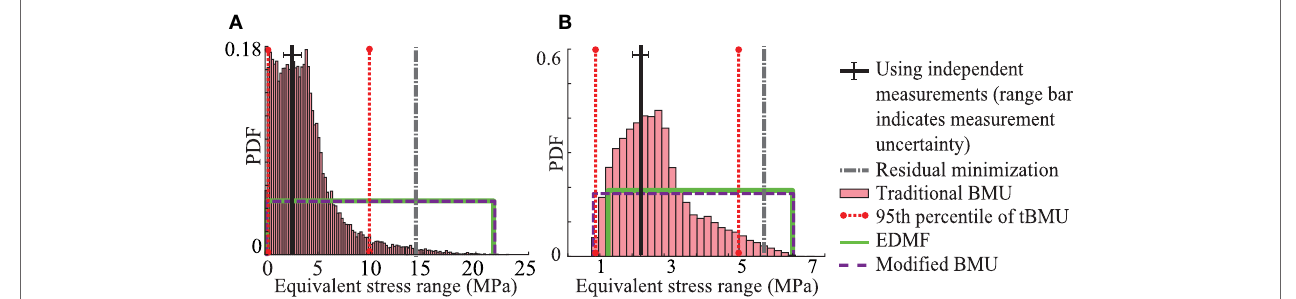
FIGURE 5 | Equivalent stress range predicted using updated model parameters at (A) sensor location A5 and (B) sensor location B5.